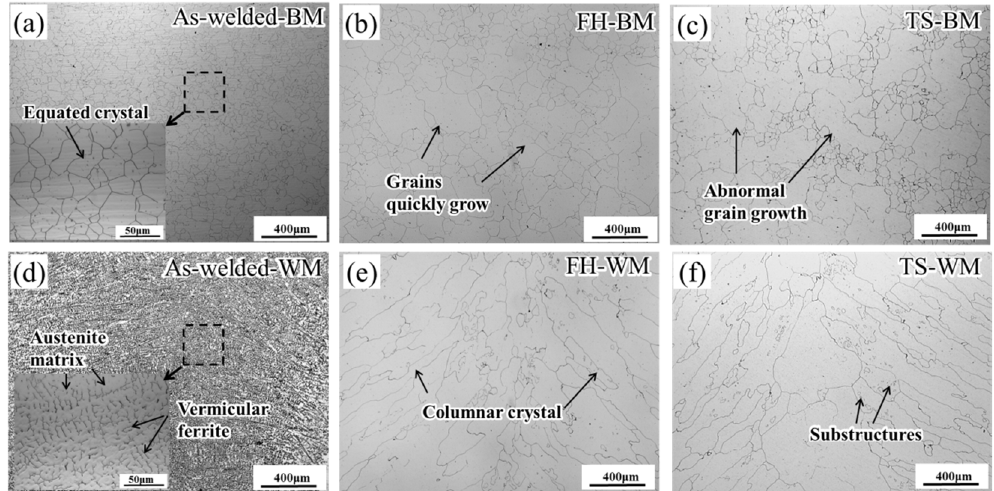
Figure 2. Optical micrographs of the 310S welded joint of the as-welded ( a , d ), FH ( b , e ), and TS ( c , f ) samples at 1100 °C (base metal (BM) ( a – c ) and weld metal (WM) ( d – f )).